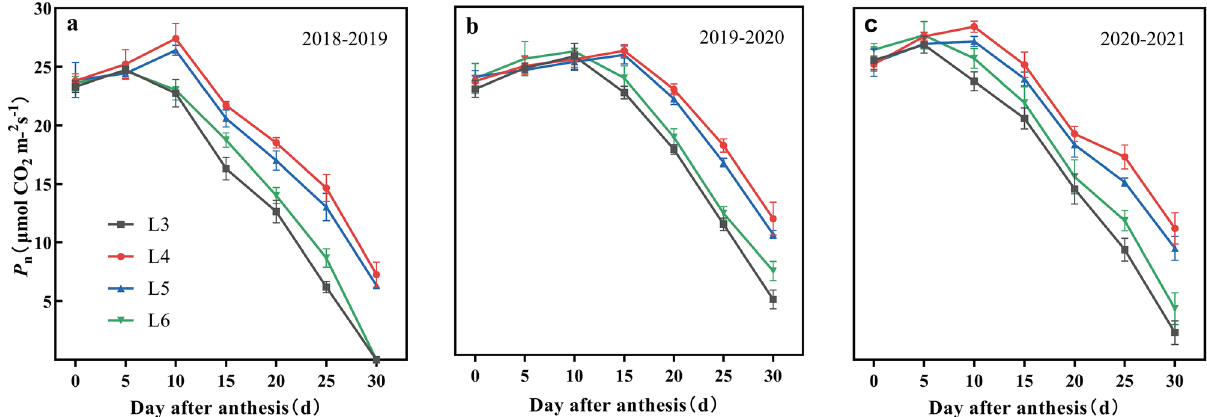
Figure 8. Effects of irrigation time on photosynthetic rate of flag leaves in 2018–2019 ( a ), 2019–2020 ( b ) and 2020–2021 ( c ) years. Vertical bars represent standard errors. Pn, synthetic rate.